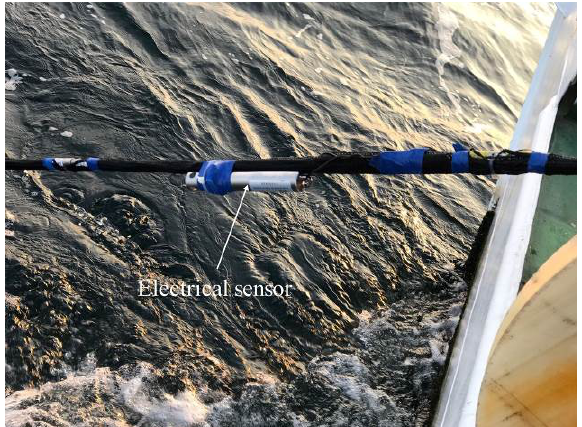
Fig. 7 Sensors entering the seawater.